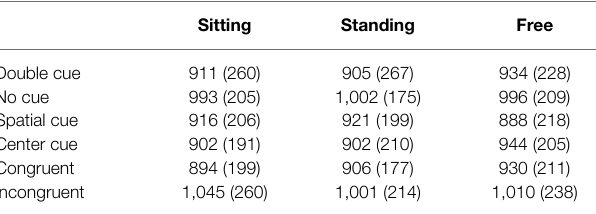
Standard deviation are in parentheses.